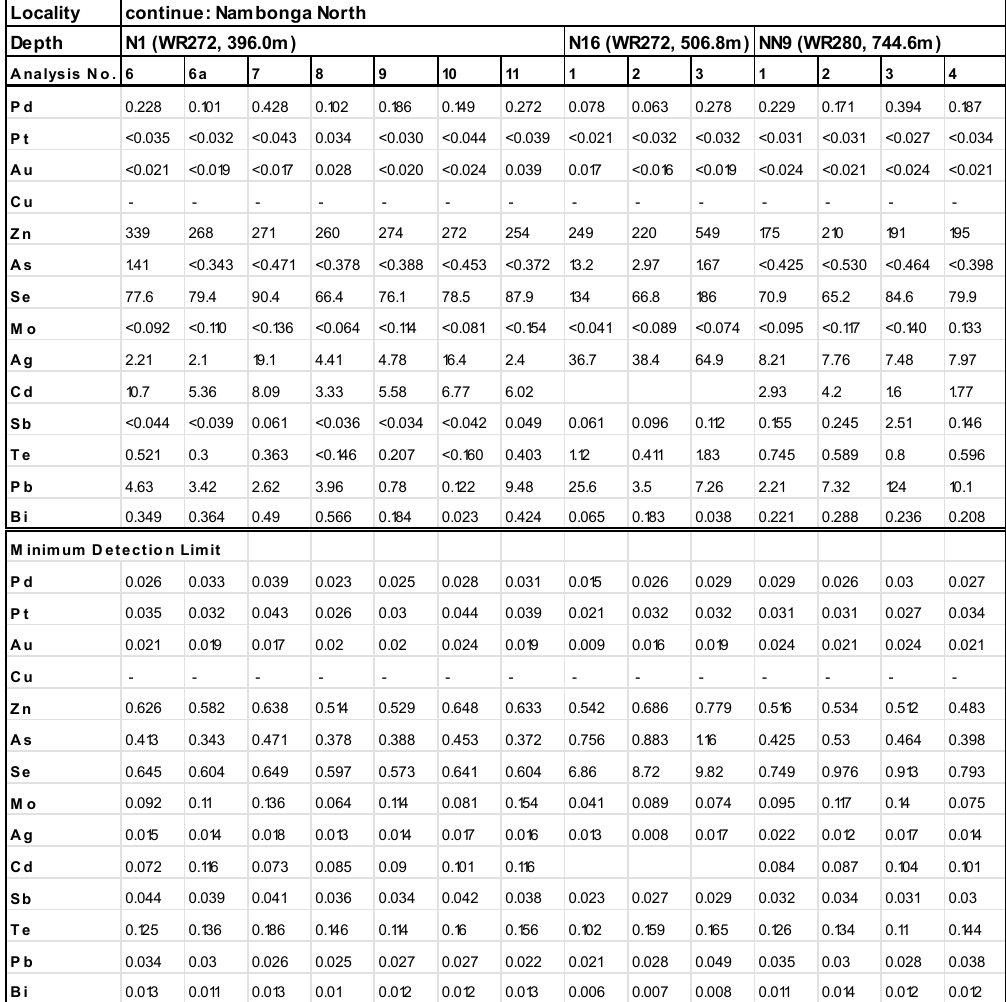
Figure A2. LA-ICPMS trace element results of chalcopyrite (all results are in ppm).